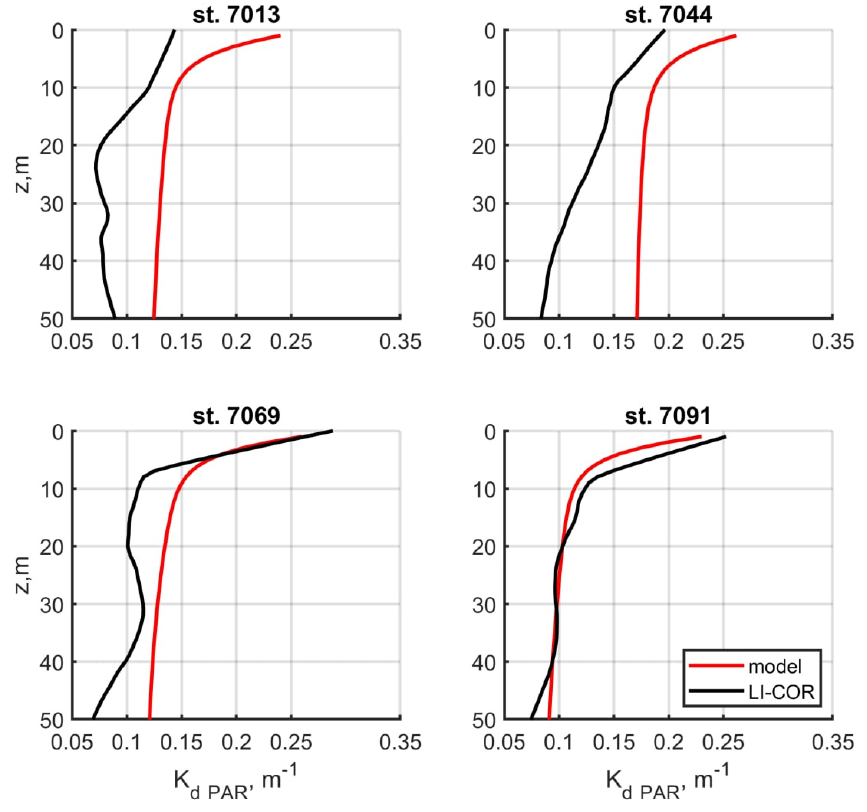
Figure 7. K d_PAR ( z ) vertical profiles in the PAR range based on data of direct determinations (black lines) and modeling (red lines).